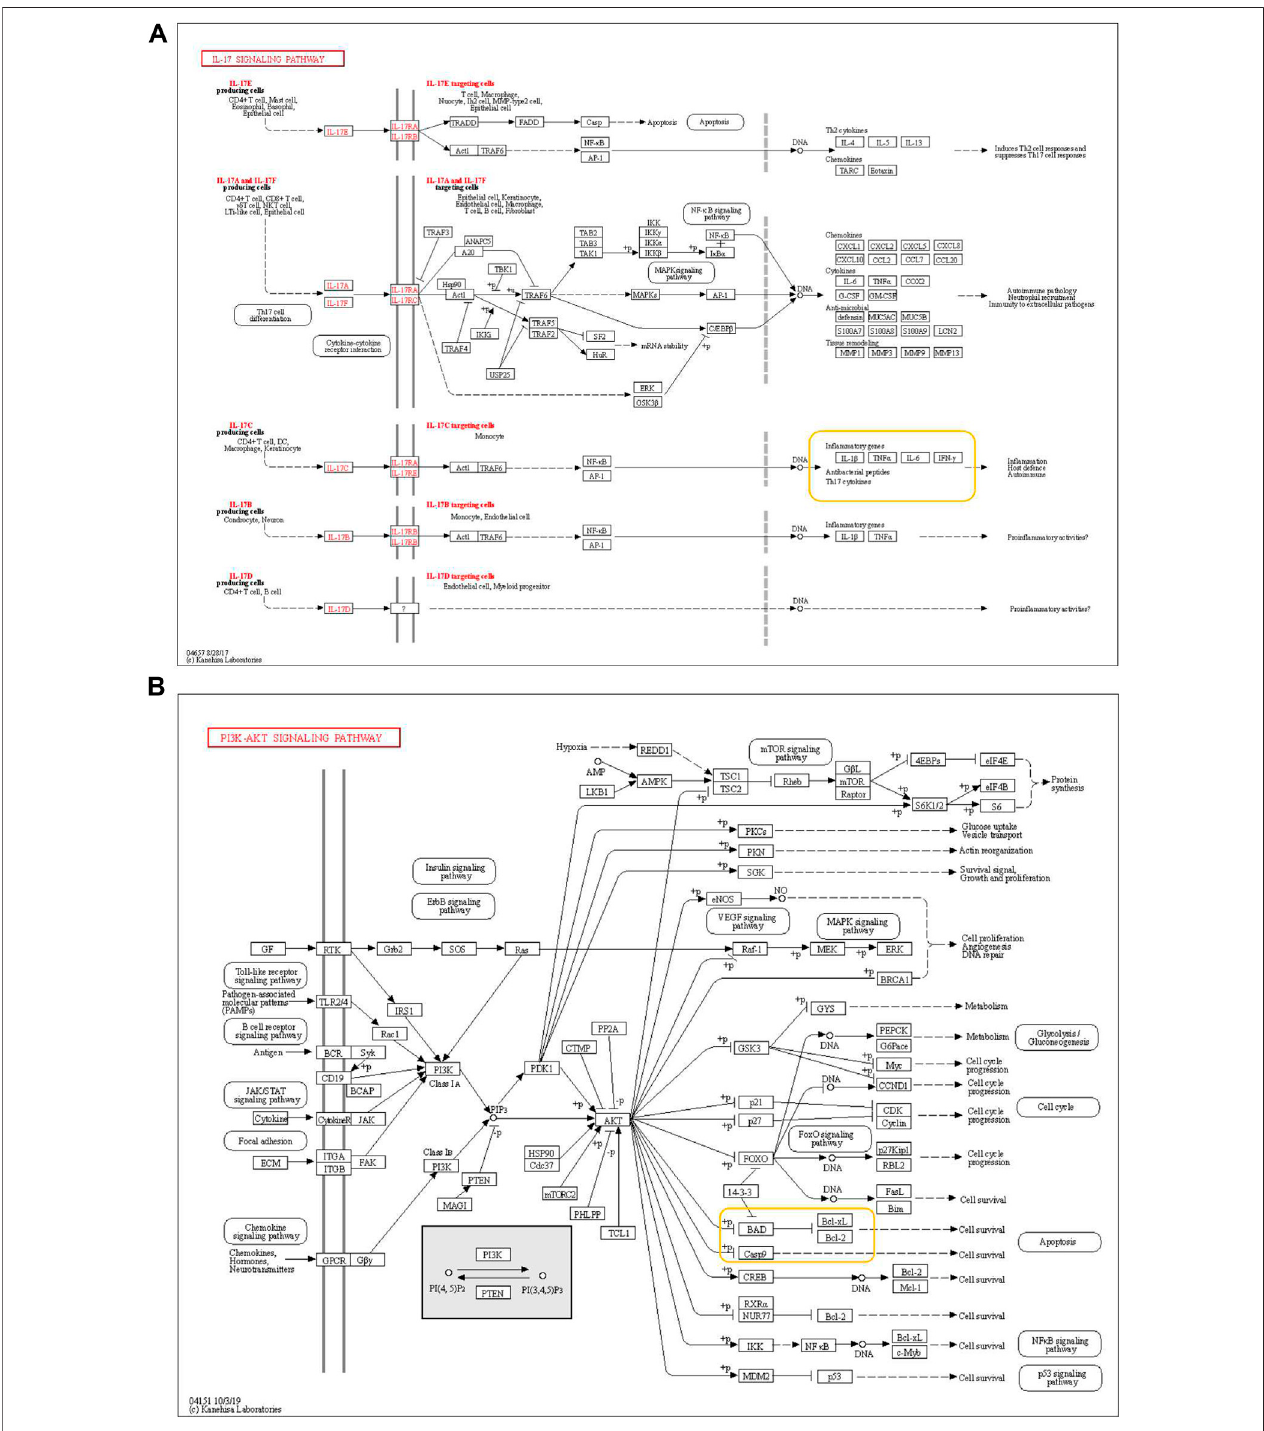
FIGURE 5 | Pi3K-Akt and IL-17 signaling pathway (A) PI3K-Akt signaling pathway and (B) IL-17 signaling pathway, with key target genes in the yellow box.